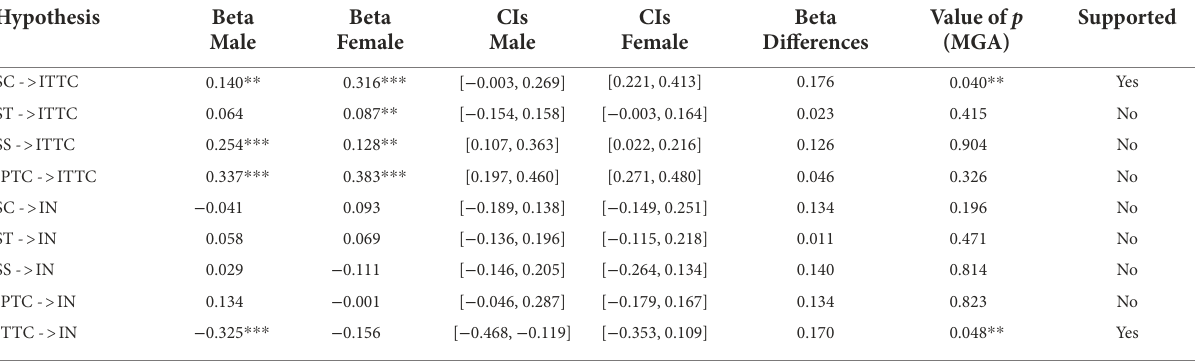
TABLE 9 Results of hypothesis